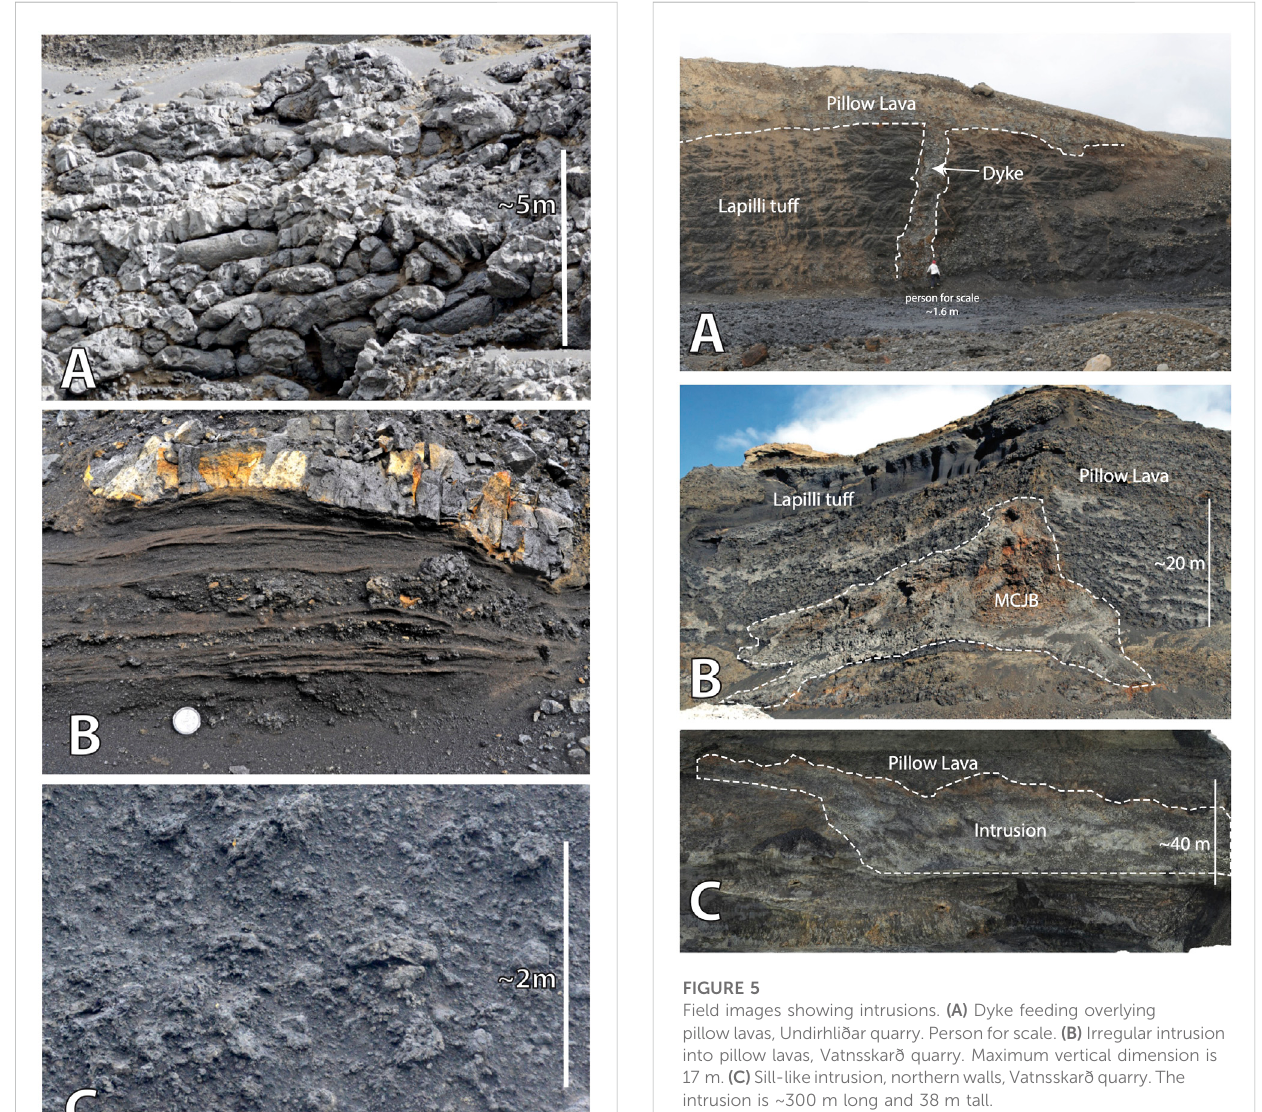
black vitric tuff breccia (TB) that dips downward and thickens to the